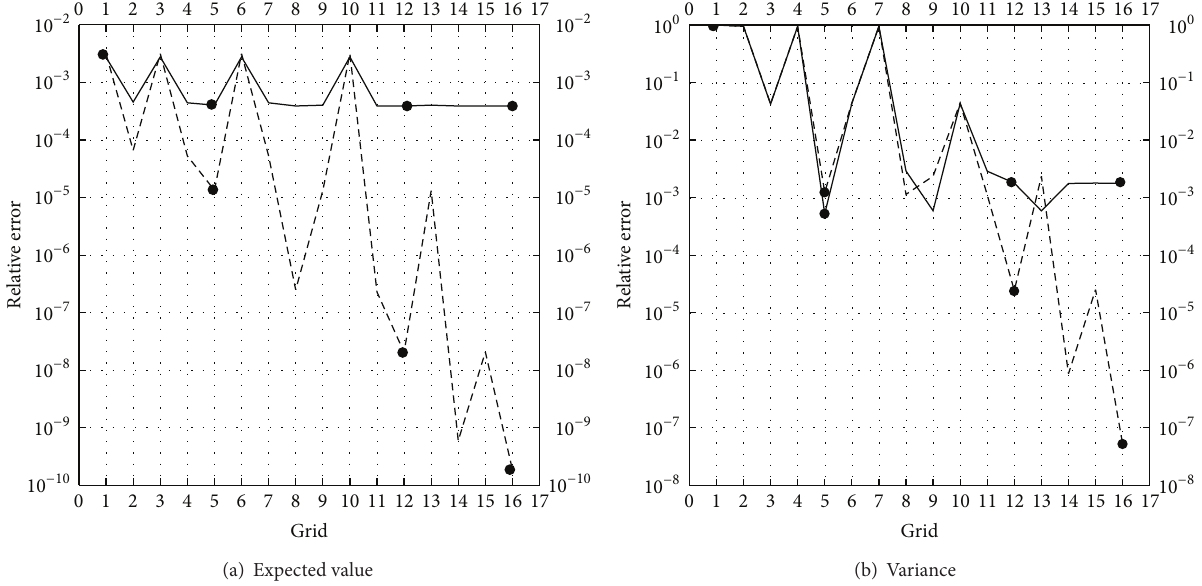
Figure 4: Case A: convergence in eigenvalue: relative error versus collocation sequences in log-scale. Dashed line: fixed deterministic discretization in reference. Solid line: higher resolution reference. Plotmarkers: uniform collocation grids.